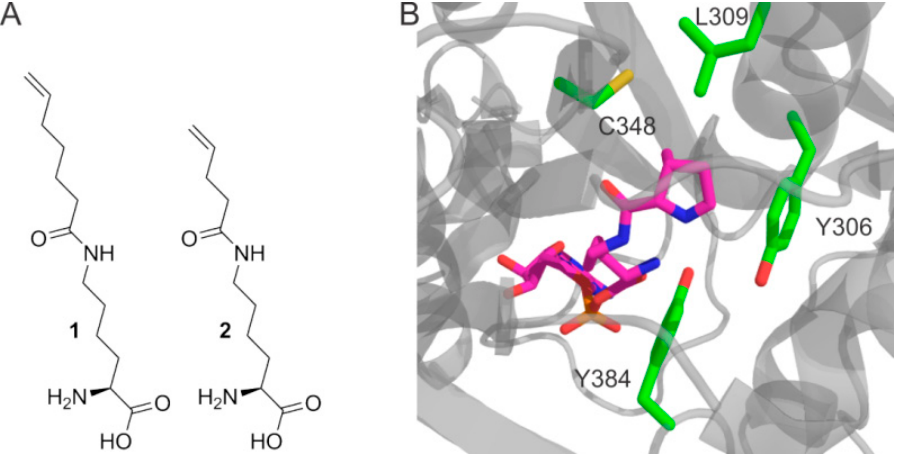
Figure 1. Incorporation of noncanonical amino acids. ( A ) Amino acids N ε -heptenoyllysine (Hek, 1 ) and N ε -pentenoyllysine (Pek, 2 ) used in this study; ( B ) The amino acid binding pocket of Methanosarcina mazei PylRS binding the natural substrate pyrrolysine-AMP (pink), from PDB id 2ZIM [16]. Residues modified in this study are highlighted (green).